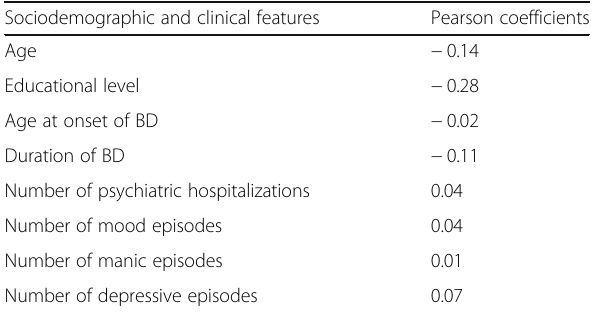
Table 4 Correlation coefficients between total score of neurological soft signs and sociodemographic and clinical features of bipolar I patients Sociodemographic and clinical features